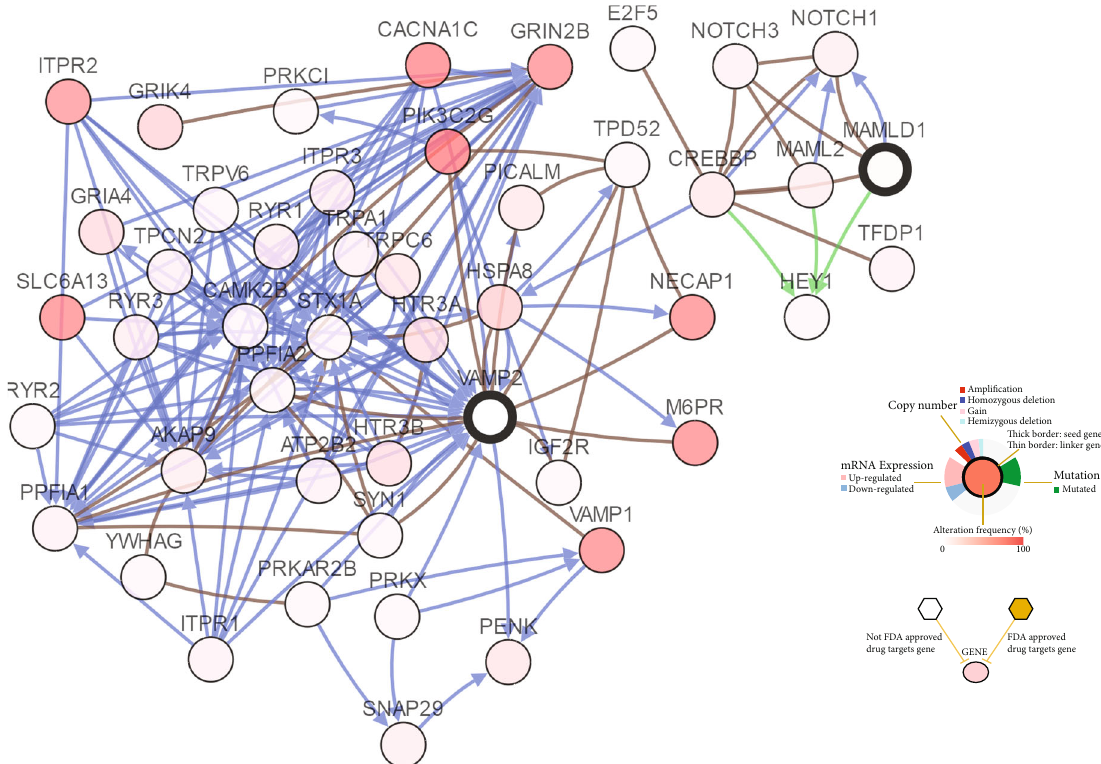
Figure 5: Protein-Protein Interaction (PPI) network. (a) PPI network diagram between nine risk-related genes and their related